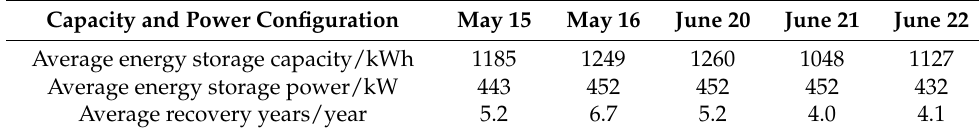
Figure 18. Box plot of ESD capacity demand, ESD power demand and recovery year based on random load. Table 10. ESD configuration and cost recovery years through comprehensive optimization.